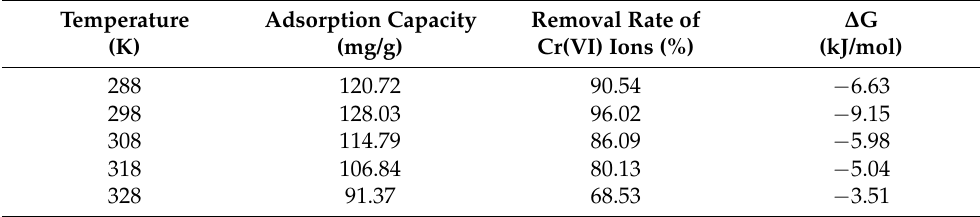
Table 5. Effect of temperature and the Gibbs free energy change at different temperatures. Temperature Adsorption Capacity Removal Rate (K) (mg/g)